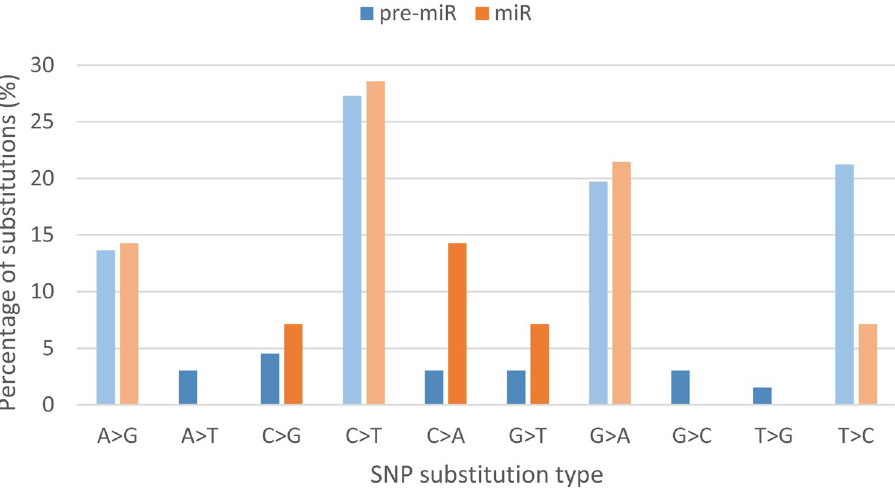
Figure 3. Details on the frequency of SNP substitution types identified in the whole pre-miRNA sequences (pre-miR) as well as mature miRNA sequences (miR). Lighter-coloured bars denote transitions, while darker- coloured bars stand for transversions.